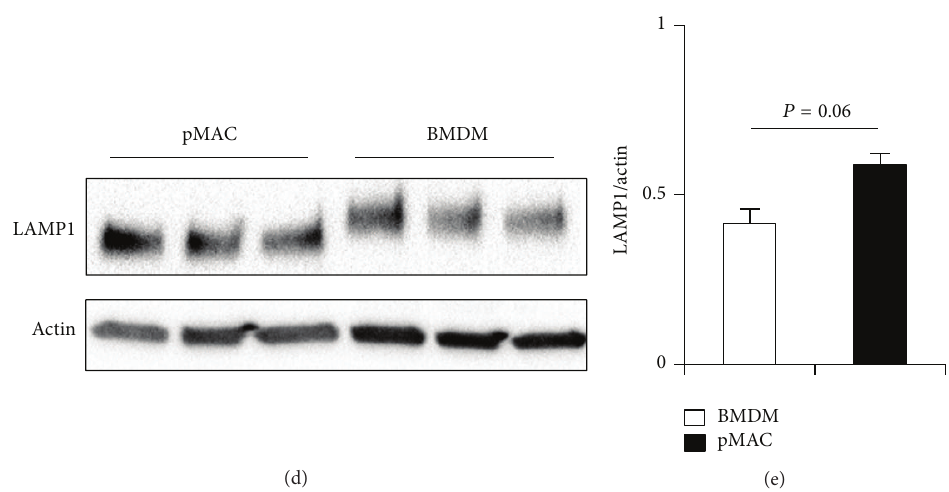
Figure 3: Expression of lysosomal genes is enhanced in pMACs. (a) RNA was isolated from pMACS and BMDMs and expression of the indicated lysosome and autophagy genes was determined by qRT-PCR. Expression was normalized to 36B4. (b, d) Total cellular protein was isolated from pMACs or BMDMs and expression of pro-cathepsin D (ctsD; (b)) or LAMP1 (d) was determined by western blotting. (c, e) Quantification of pro-cstD protein (45kD) expression (c) or LAMP1 (110–120kD) (e) normalized to actin. Bar graphs report the mean ± SE for a minimum of 2 experiments, each performed in triplicate. ∗ 𝑃 < 0.05 for pMAC versus